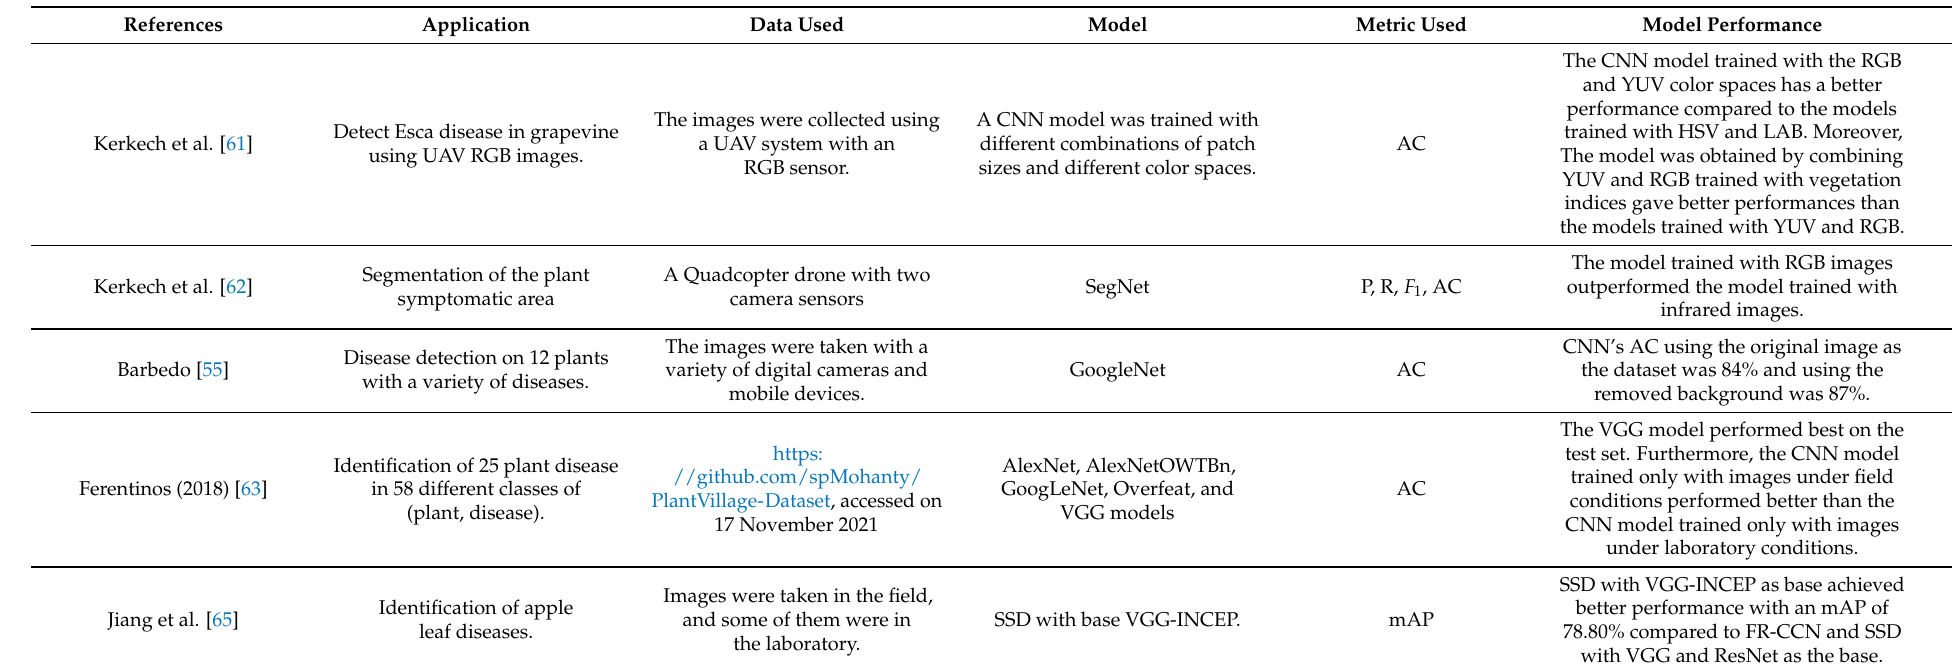
Table 1. Feature descriptions of recent published papers in the field of “Disease